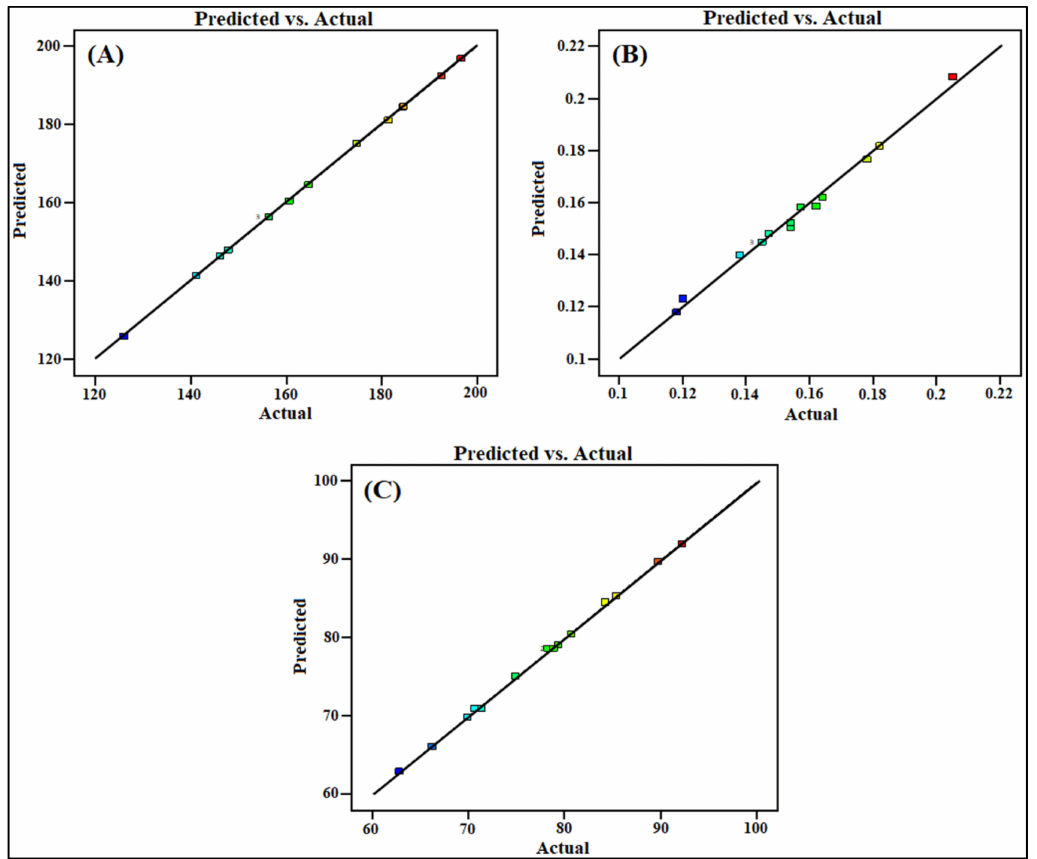
Figure 3. Actual and predicted graph showing linear correlation ( A ) PS, ( B ) PDI, ( C )